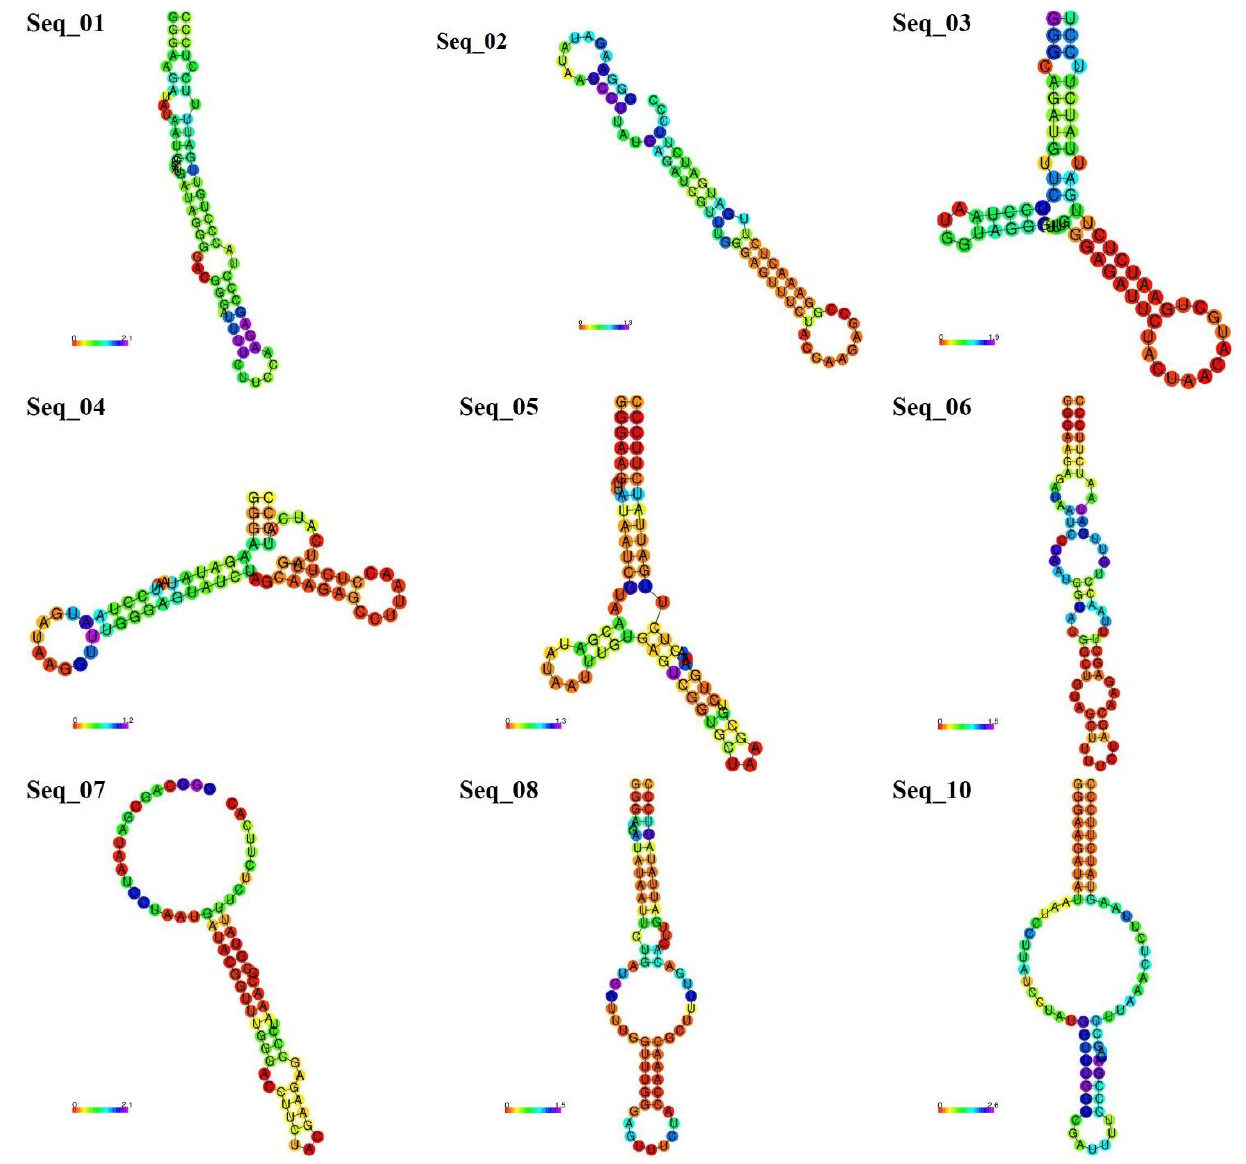
Figure 1. Secondary structures of the newly generated sequences from seq_1 to seq_10 (except seq_09). Nucleotides are colored according to their positional entropy, as shown on the horizontal bar. Red and orange colors indicate lower entropy, while blue colors indicate higher entropy.